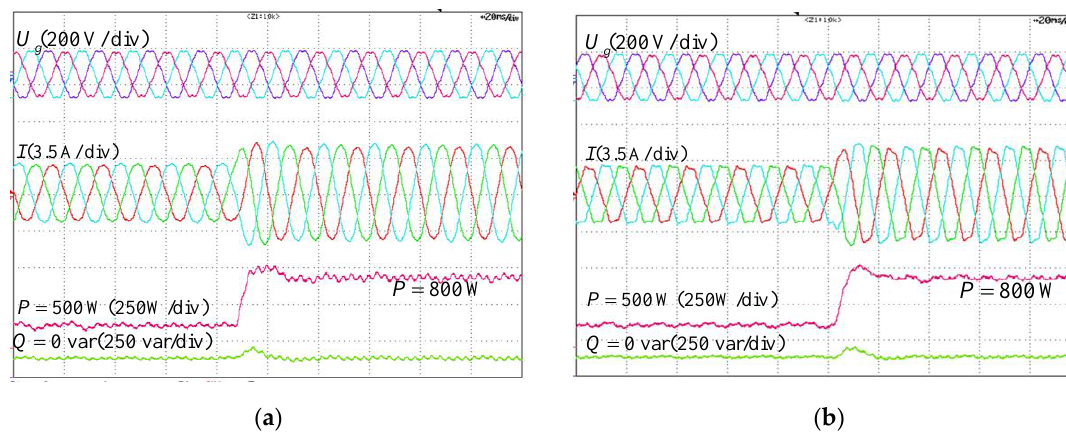
Figure 11. Power regulation of VSC under integer harmonics grid with the proposed control. ( a ) Power regulation with the target I; ( b ) Power regulation with the target II.